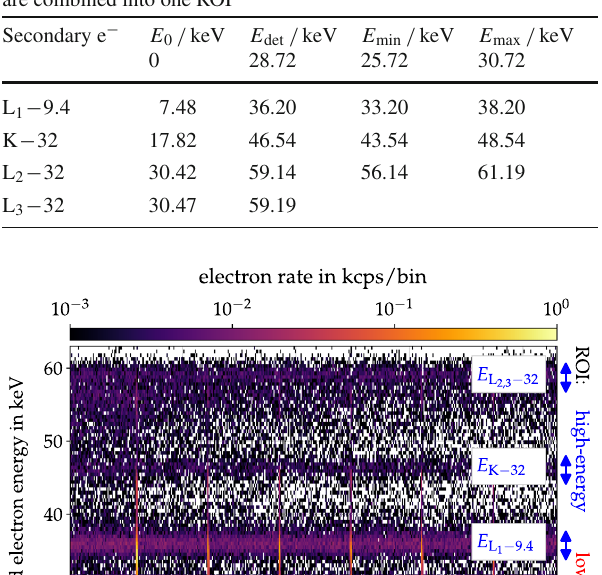
Fig. 4 Removal of stored electrons originating from a 83m Kr source by themagneticpulse.ThepulsewasappliedbyinvertingLFCSaircoilL8 for 1s with the flip-box prototype. Top: the energy spectrum shows lines of high-energy primary electrons from 83m Kr decay ( E L E L ) and low-energy secondary electrons ( E ≈ 0 eV). Bottom: 2 , 3 − 32 the observed rate in both energy regimes – low-energy (red) and high- energy (blue) – is reduced by applications of the magnetic pulse. The rate increases after each pulse from continuous 83m Kr decays in the spectrometer. The “rate spikes” are a result of the flux tube